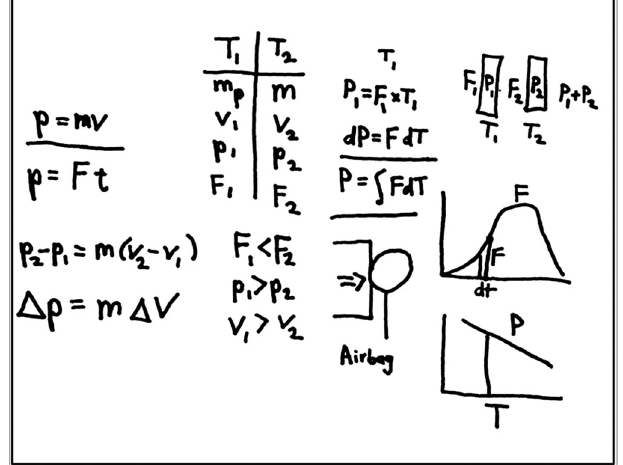
FIG. 2. Sketch of the blackboard after Amber’s lesson 4 pre- sentation. (Our videotaped screen shot would be difficult to read.) Amber uses both ‘‘ T ’’ and ‘‘ t ’’ to represent